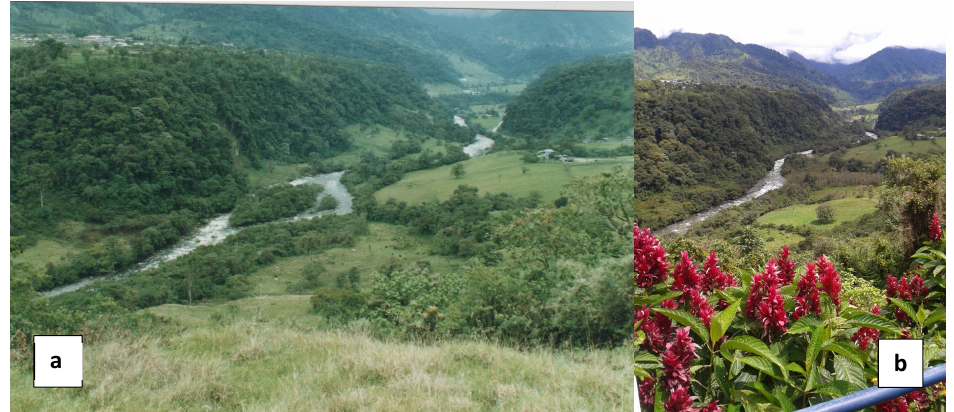
Figure 3. Panoramic view of the Quijos River at the mid-course level, near the town of Baeza at the Hostería Cumandá location, at the edge of Cumandá Protected Forest. ( a ) The left picture from 2010 shows the large isle that the white-waters course isolated in its rapid flow downslope. ( b ) In the picture on the right, taken in 2020, the isle is no longer visible in just one decade, due to human encroachment at the riverbank. Source ( a ) Photo from Jack Rodr í guez, 15 September 2002. Source ( b ) Photo from Neotropical Montology Collaboratory, 6 July